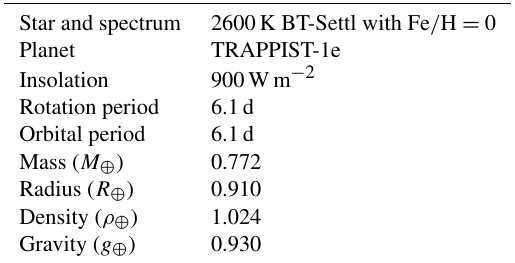
Table 1. TRAPPIST-1 stellar spectrum and TRAPPIST-1e planetary parameters from Grimm et al.